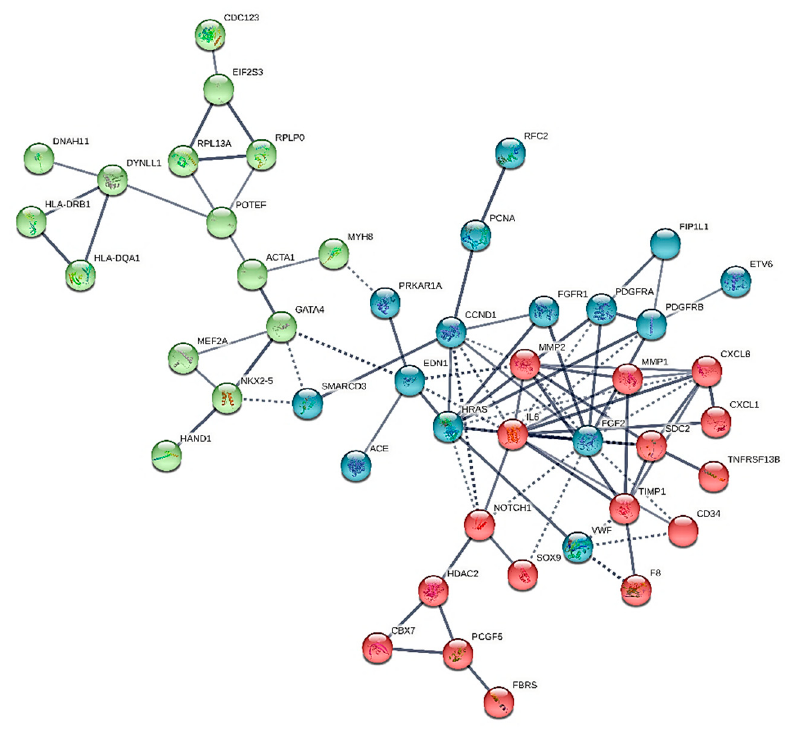
Figure 3. The heart rhabdomyosarcoma interactome.